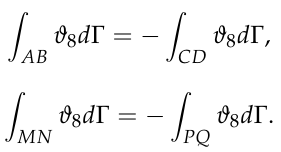
Figure A2. Region 8 fictitiously divided into a simply connected region.